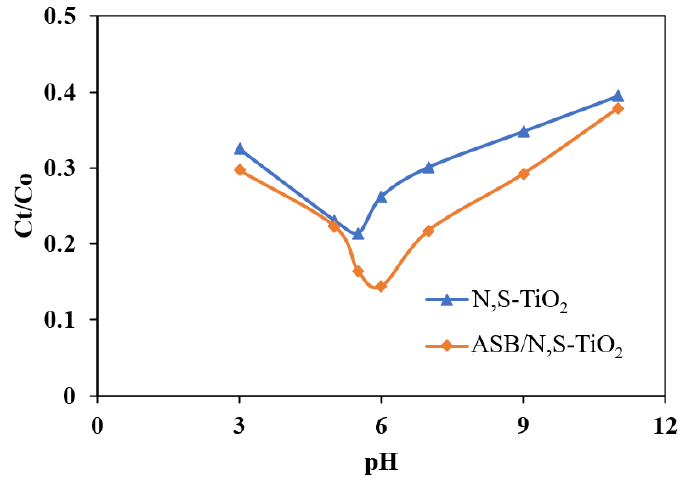
Figure 6. Effect of pH on removal for N,S-TiO 2 and ASB/N,S-TiO 2 composites (condition: contact time = 150 min irradiation, [CIP] 0 = 30 ppm, dosage = 0.05